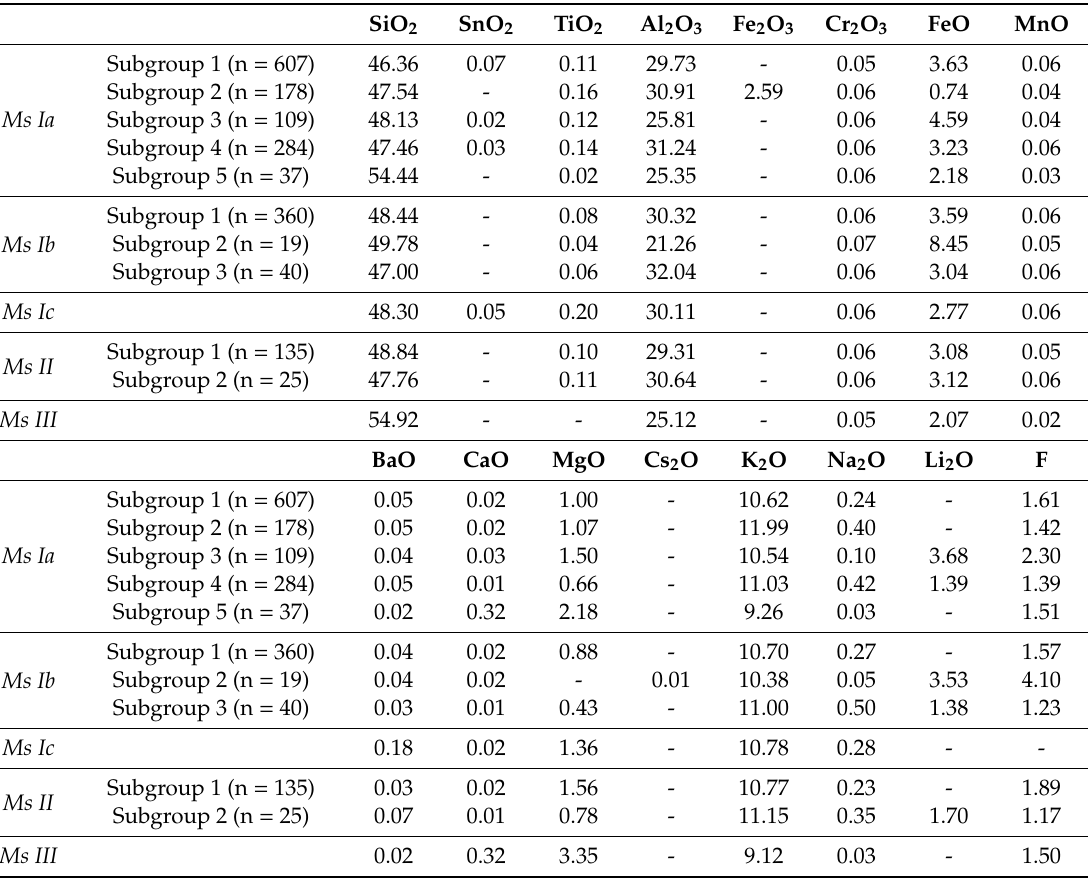
Table 2. Elemental median concentration values (wt %) characterizing each white mica